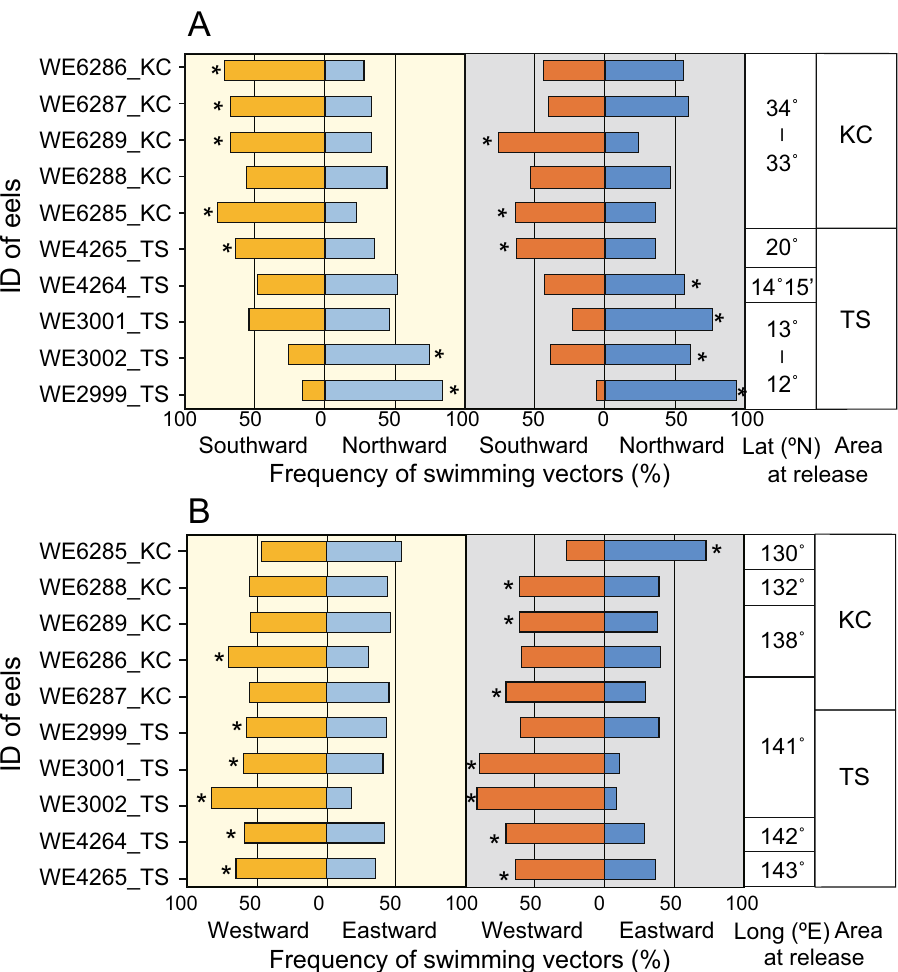
Figure 5. Frequencies of swimming directions of tracked eels in meridional and zonal axis. ( A ) Frequency of northward and southward swimming vectors during daytime (yellow shading) and nighttime (gray shading). Vectors with the bearing of 0°–90° and 270°–360° are categorized as northward, while those at 90°–270° are southward. Eels released at higher latitudes are ordered from the top. The latitude and area of release points are shown in the right box. B. Frequency of eastward and westward swimming vectors during daytime and nighttime. Vectors with the bearing of 0°–180° and 180°–360° are eastward and westward, respectively. Eels released at more west positions are ordered from the top. The longitude and area of release points are shown in the right box. Asterisks (*) indicate a significant difference in comparison with a uniform expected frequency under the null hypothesis by Chi-square test ( P <